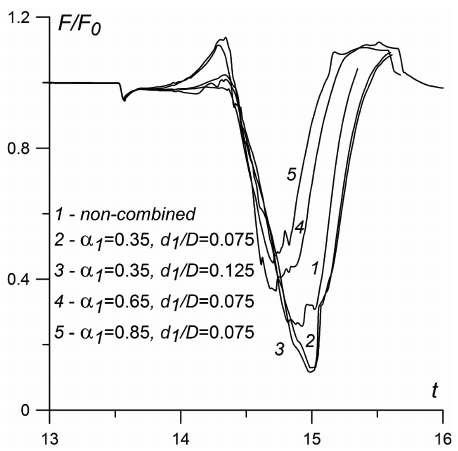
Figure 4. Dynamics of frontal drag force for non-combined and combined filaments for d/D = 0.25, Δ l/D = 4, α ρ = 0.5 and different values of α ρ 1 and d 1 /D .